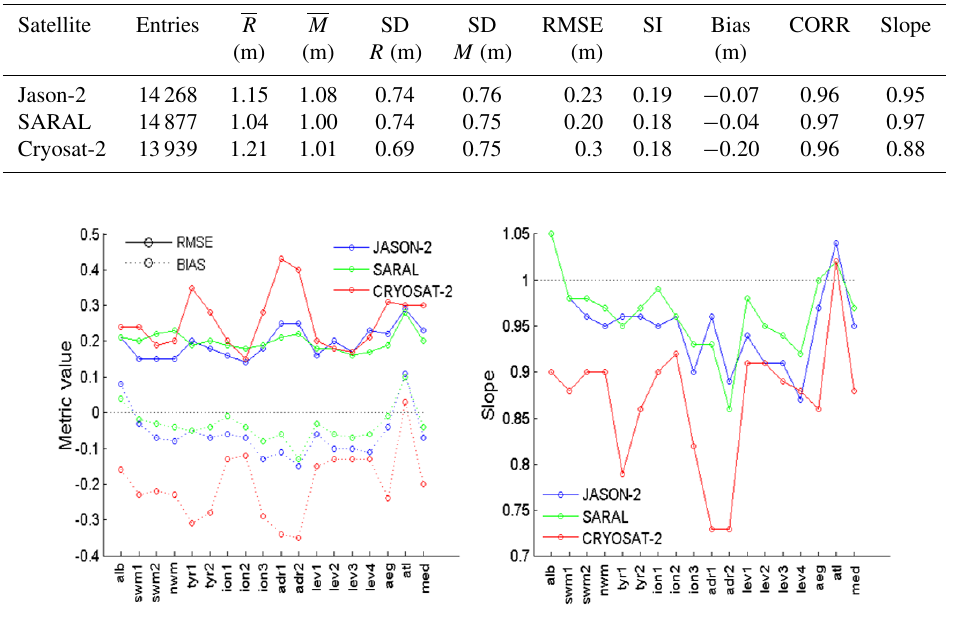
Figure 6. Med-waves H s evaluation against satellite H s , for each Mediterranean Sea subregion shown in Fig. 3, for a 1-year period (2014).